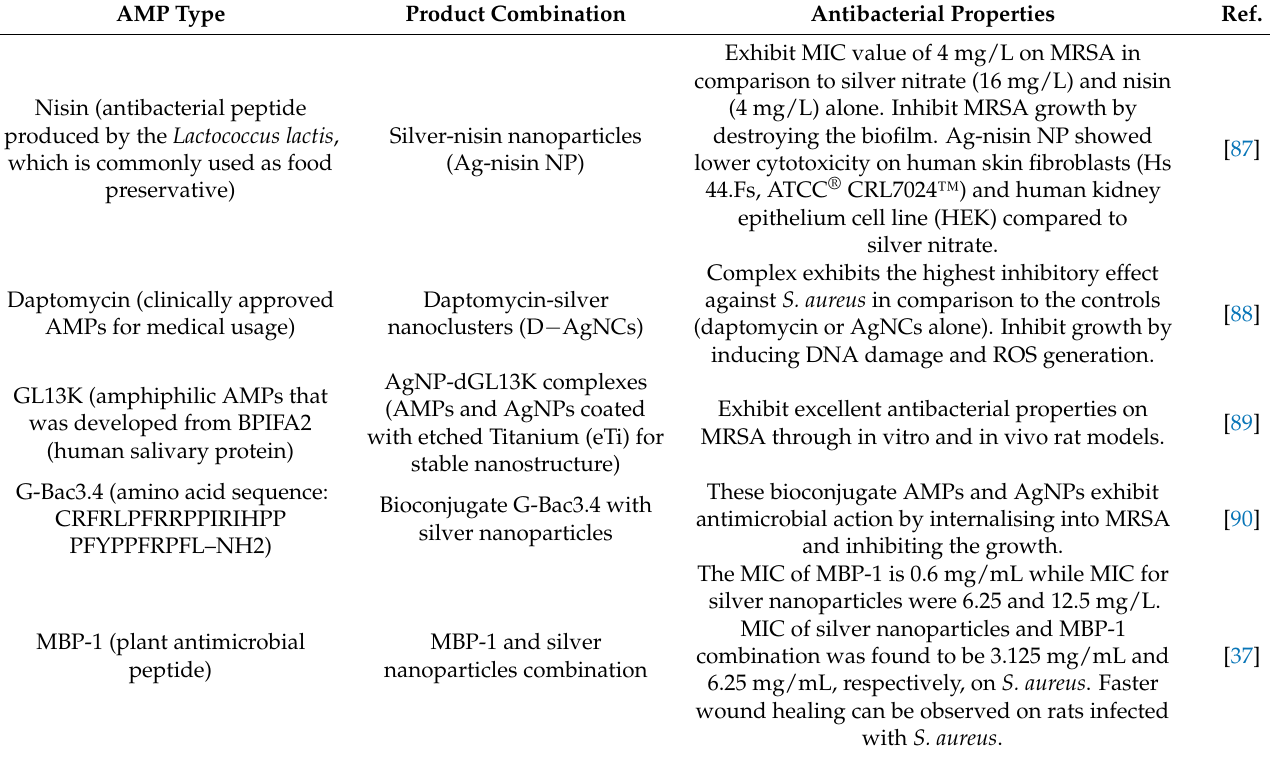
Table 3. Combinations of AMPs and AgNPs with addition of polymer for inhibiting S. aureus or MRSA